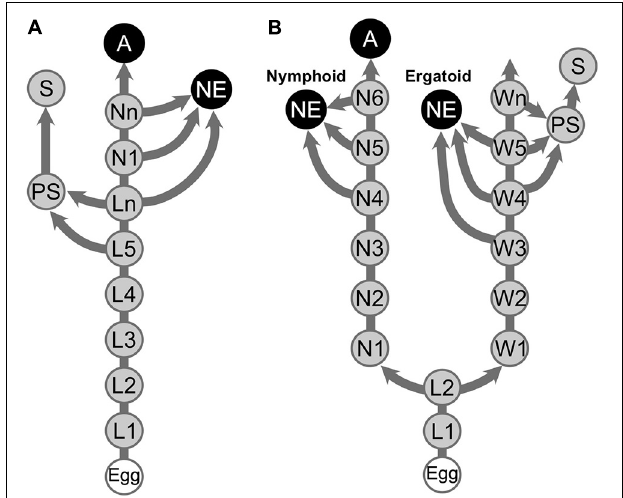
FIGURE 1 | Representative caste developmental patterns in termites. (A) Linear pathway. (B) Bifurcated pathway. Arrows indicate hatching and molts. A, Alate; L, Larva; N, Nymph; NE, Neotenic reproductive; PS, Presoldier; S, Soldier; W, Worker. Elder larvae (Ln) in the linear pathway are referred to as “pseudergates” in this